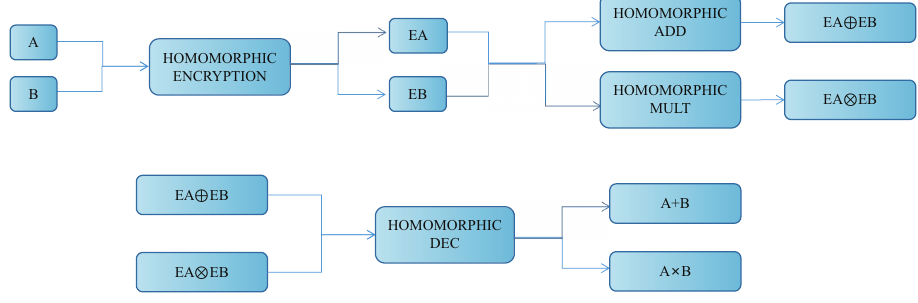
Figure 1. Homomorphic addition and